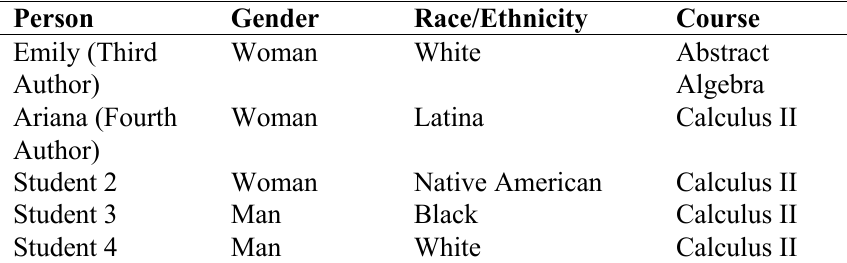
Demographic Data of